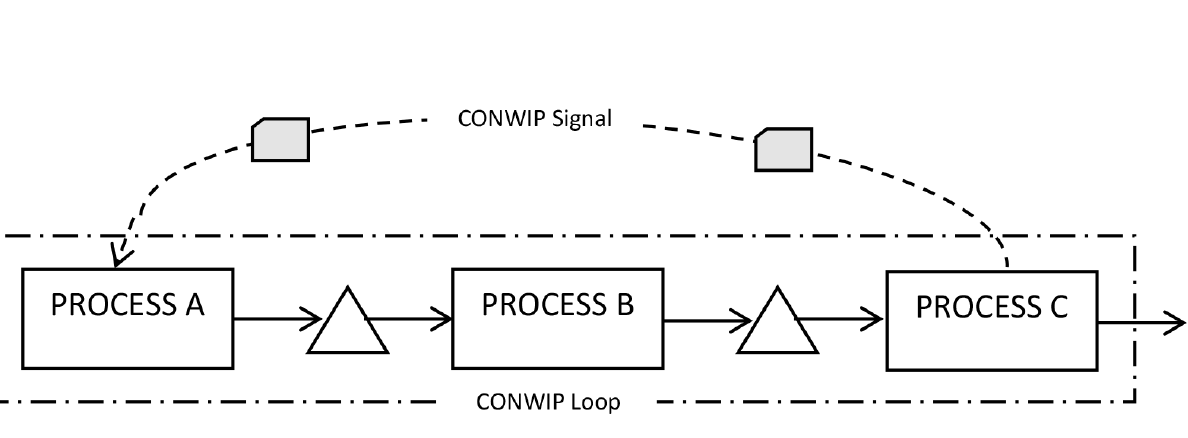
Figure 1. Simple CONWIP